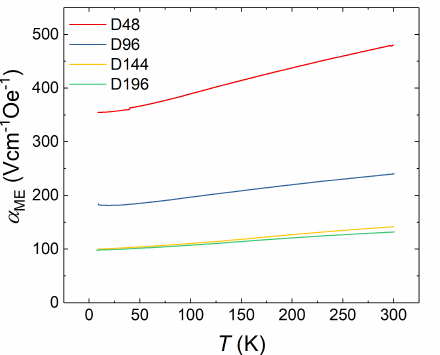
Figure 5. α ME values measured in 0T at 300K for the ( a ) BTO-BFO thickness ratio series; ( b ) p O ( c ) d dl series; and ( d ) repetition n of double layers in a BTO-BFO multilayer stack (data adapted from [11]). The as-measured magnoelectric (ME) voltages are marked in blue, the α ME values in red.